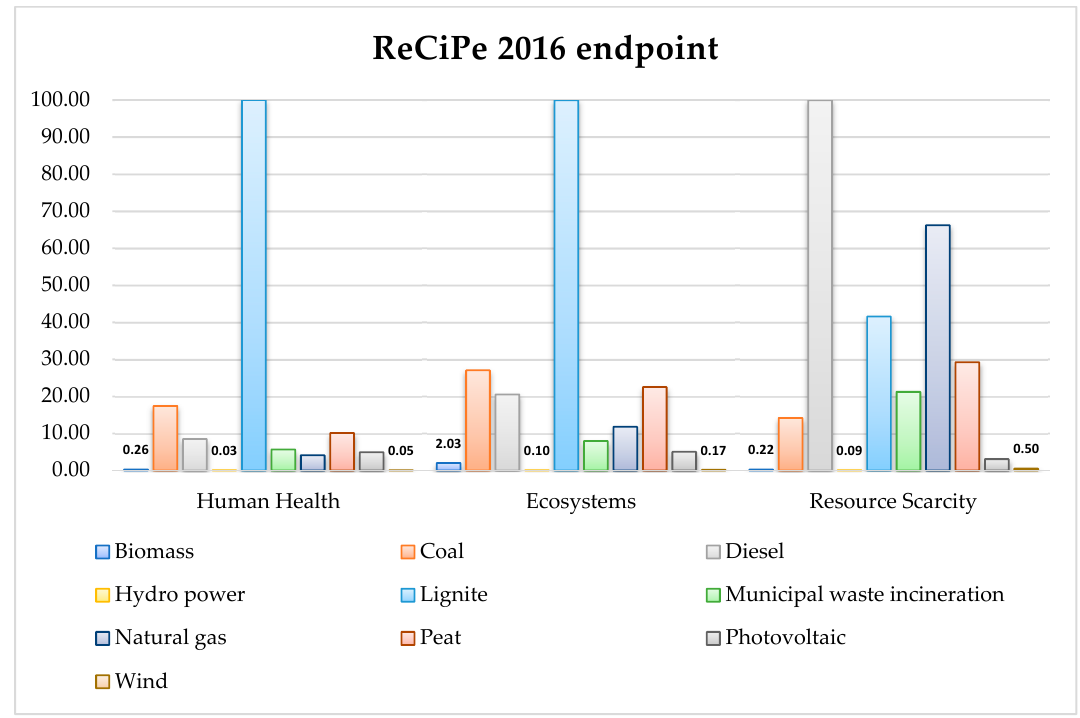
Figure 7. ReCiPe 2016 endpoint results for human health, ecosystems, and resource scarcity, expressed as a relative percentage.